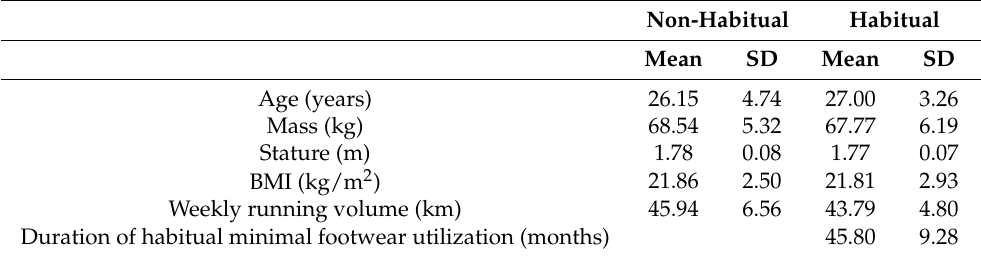
Table 2. Participant characteristics.